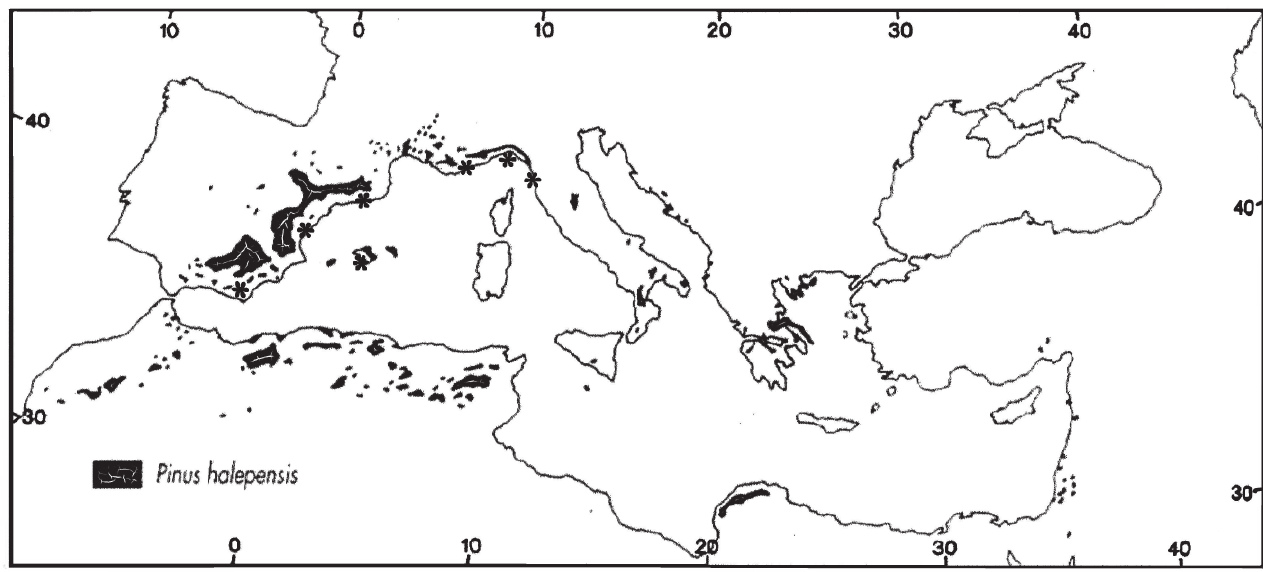
Fig. 1. Occurrence of Aleppo pine knot disease in the Mediterranean region (*) based on literature data and authors’